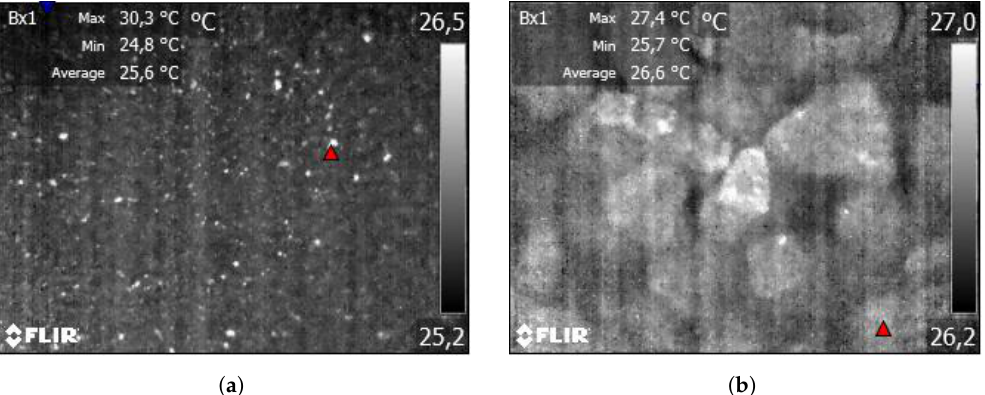
Figure 11. IR images in the first approach (macro images) with pure copper visible as bright spots. Ore particles of size: ( a ) 0–0.1 mm; ( b ) 1–2